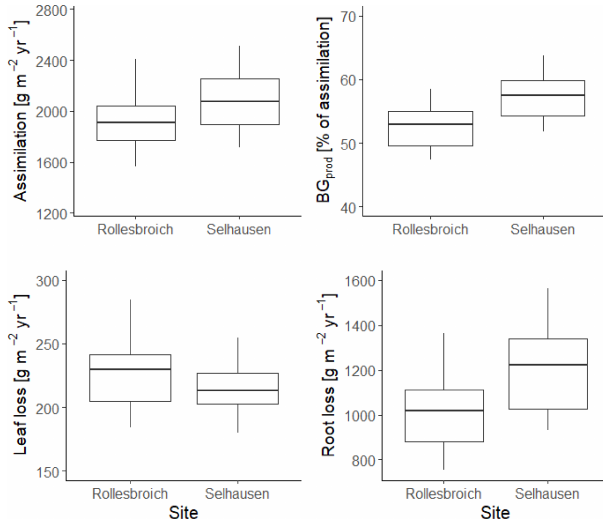
Figure 12. Box-and-whisker plots showing the simulated terms in the dry-matter balance for the 30 acceptable model parameteriza- tions at Selhausen and Rollesbroich for the period 2013–2018. For an explanation of the box-and-whisker plots, see the caption of Fig.